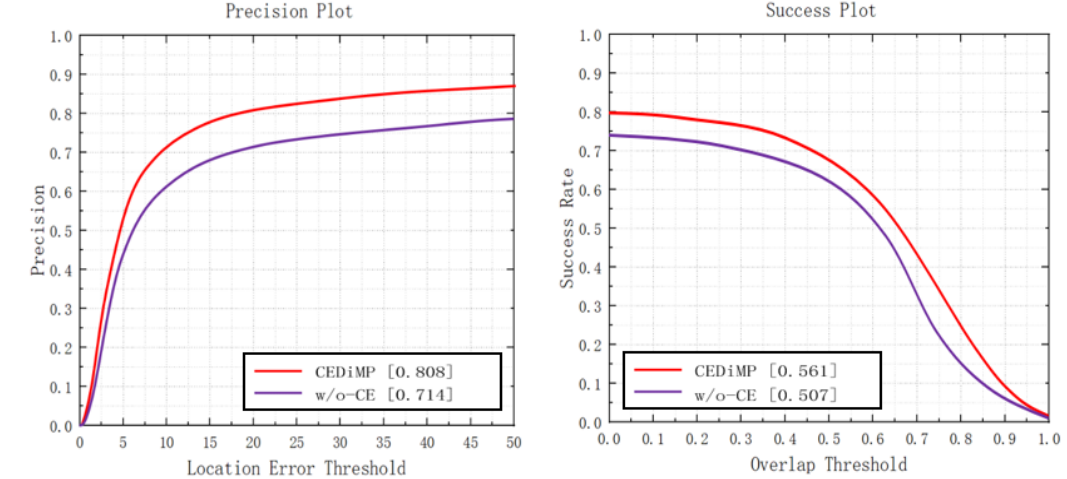
Figure 14. Comparison results w/o-CE.